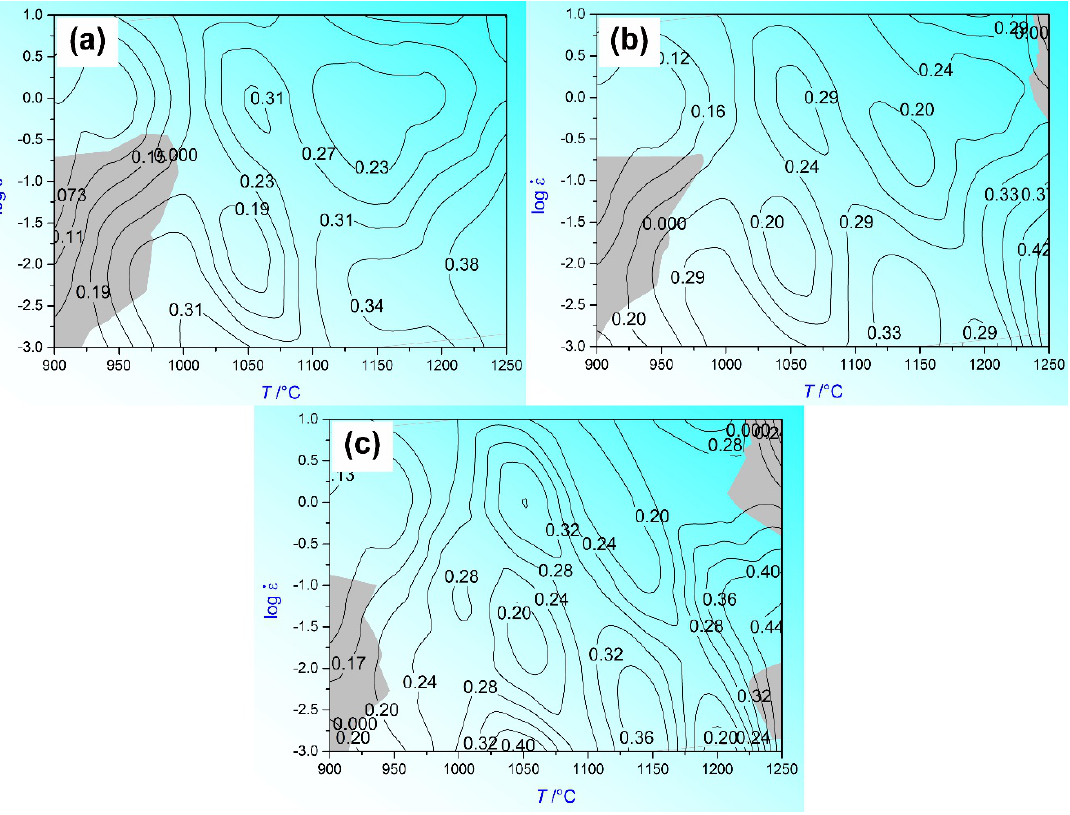
Figure 6. The processing maps of coarse-grained S31254 SASS at strain of 0.2 ( a ), 0.4 ( b ), and 0.6 ( c ).